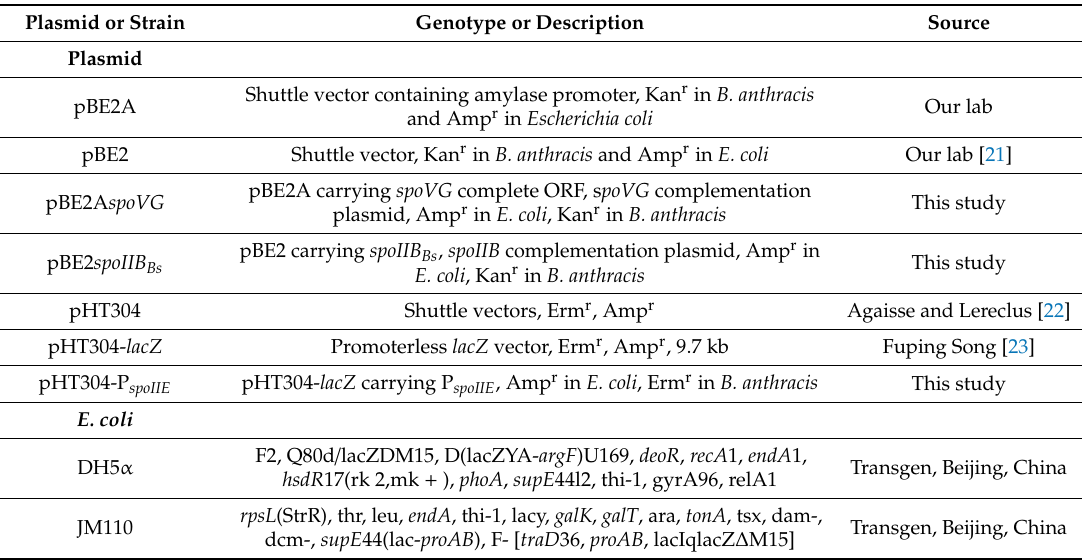
Table 1. Strains and plasmids used in this